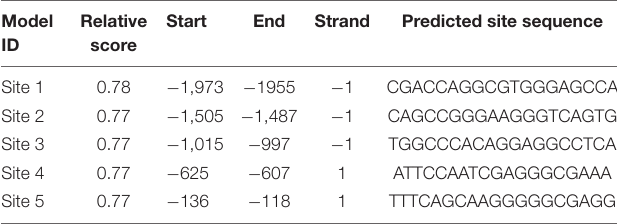
TABLE 1 | Binding site prediction of CTCF in the POLD1 promoter region.